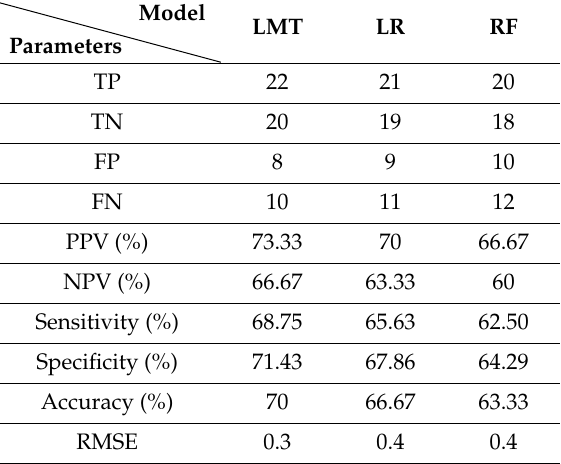
Table 5. Models’ performances based on the validation datasets.